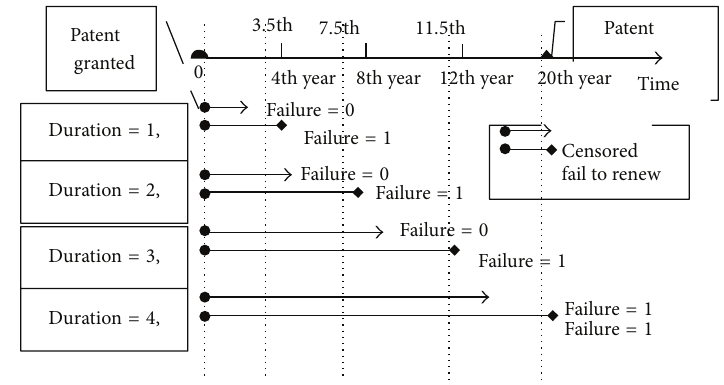
Figure 1: Patent classifications in the survival